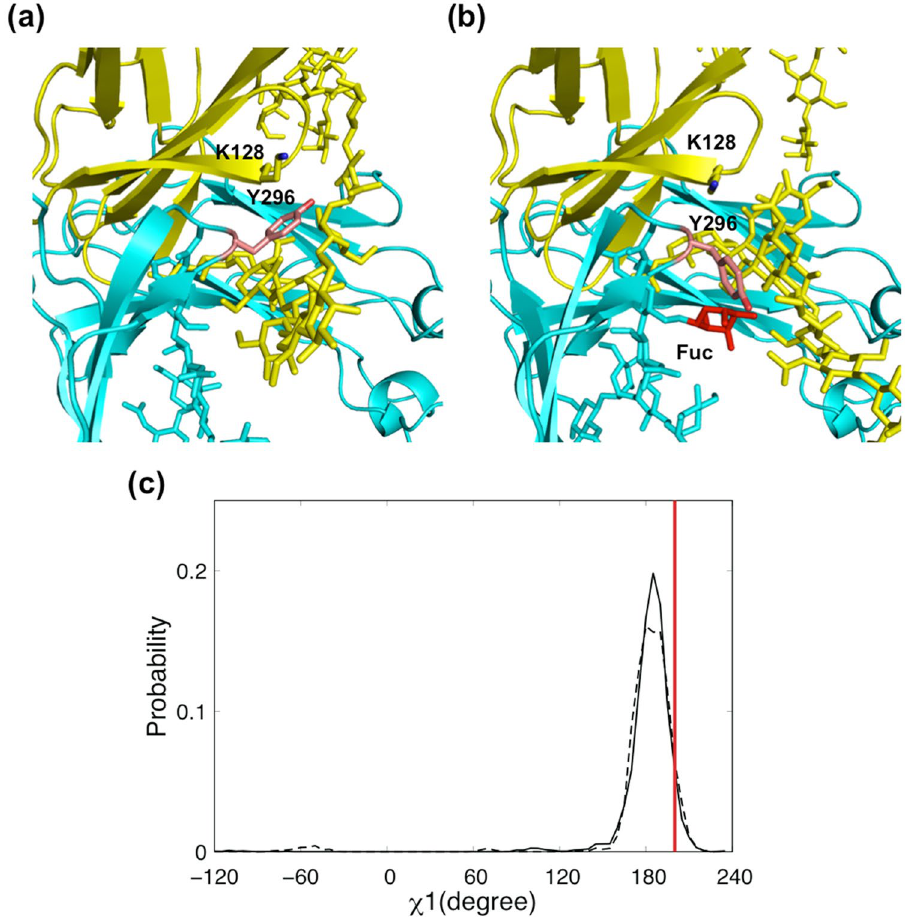
Figure 6. Conformational dynamics and rearrangements of Tyr296 of IgG1-Fc. Close-up views of the interaction interface between IgG1-Fc (cyan) and sFc γ RIIIa (yellow) are shown: ( a ) nonfucosylated system; ( b ) fucosylated system. The representative simulated structures from the nonfucosylated and fucosylated systems, in which the χ 1 dihedral angle of Tyr296 exhibited 186° and − 55°, respectively, are shown as in Fig. 4(a) and Fig. 4(b), respectively. Sugar residues, Lys128 of sFc γ RIIIa, and Asn297 and Tyr296 of IgG1-Fc are shown as sticks, while the fucose residue is colored red. ( c ) Distribution of χ 1 dihedral angles of Tyr296 of IgG1-Fc in nonfucosylated (solid line) and fucosylated (dotted line) systems. Red bar represents the χ 1 dihedral angle obtained by crystallographic